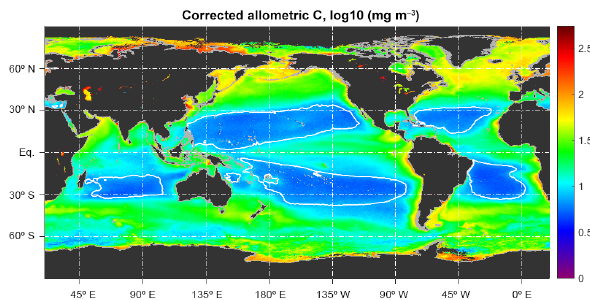
Figure 9. SeaWiFS mission composite mean (September 1997– December 2010) of total phytoplankton carbon biomass (mgCm − 3 in log10 space) calculated with the PSD method described here, as in Fig. 1a, but with an empirical correction applied to the N o pa- rameter first (see Sect.